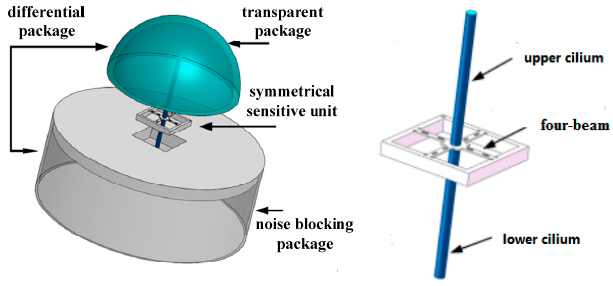
Figure 3. Structure diagram of the differential MEMS vector hydrophone.